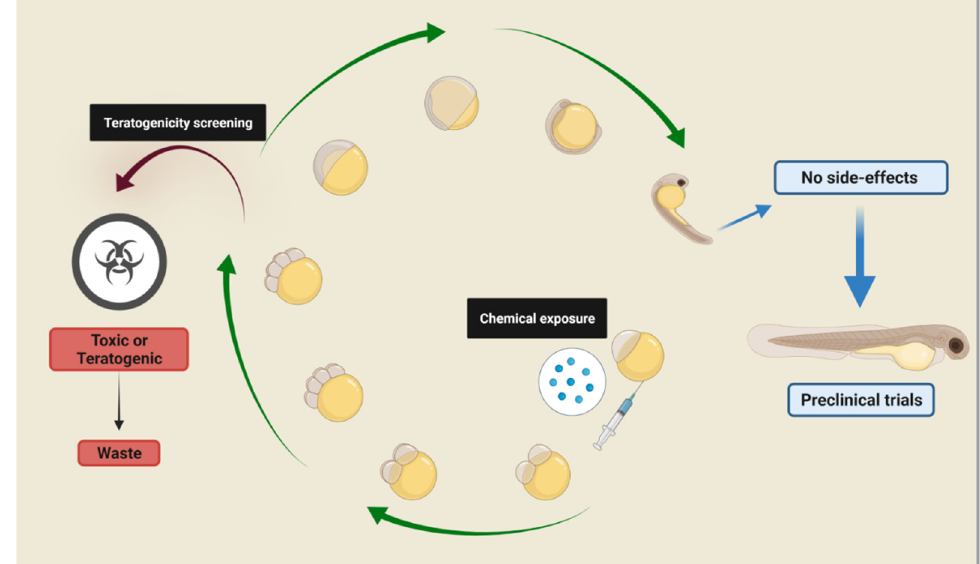
Figure 1. Zebrafish development. Zebrafish embryo-larval stages permit the phenotypic observation of the whole organism in a large-scale chemical screening. If a molecule or drug is unable to induce death or teratogenicity during the period of embryonic development, the larvae can be used to assess changes in behavior.